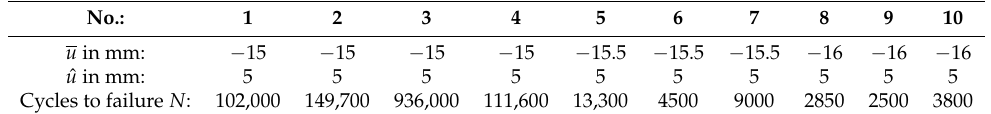
Table 1. Fatigue results in the compression range for filled EPDM rubber (displacement-controlled